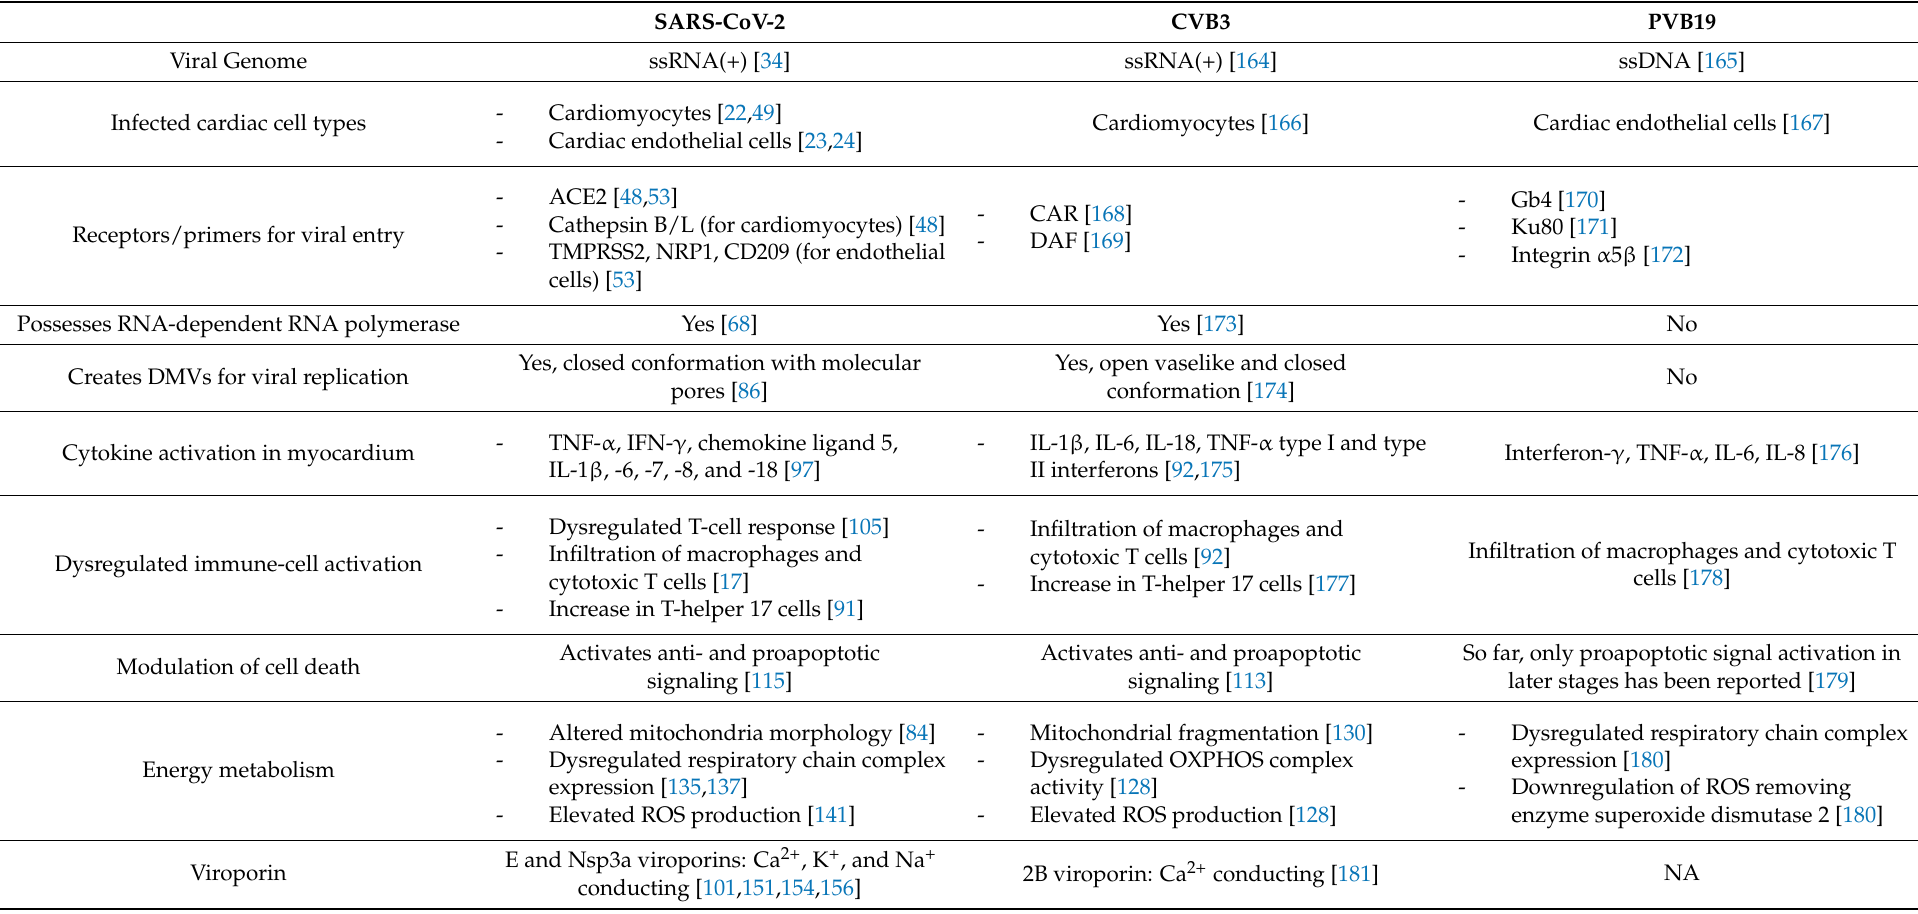
Table 2. Comparison of several virus–host interactions and viral mechanisms between SARS-CoV-2, CVB3, and PVB19 in